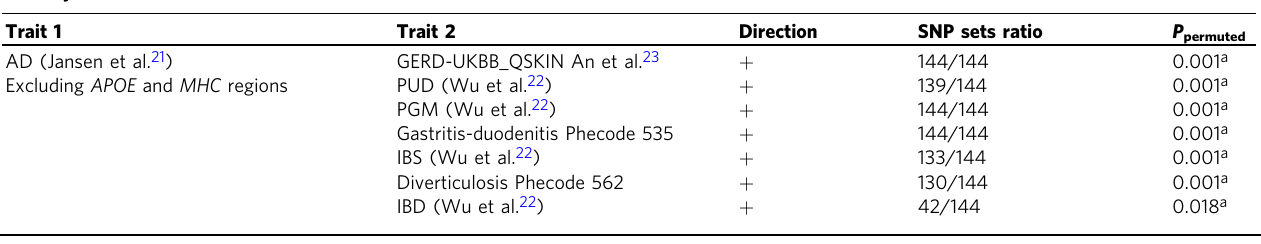
Table 3 SECA results: primary test for concordant SNP effects. Primary test for concordant SNP effects between AD and GIT